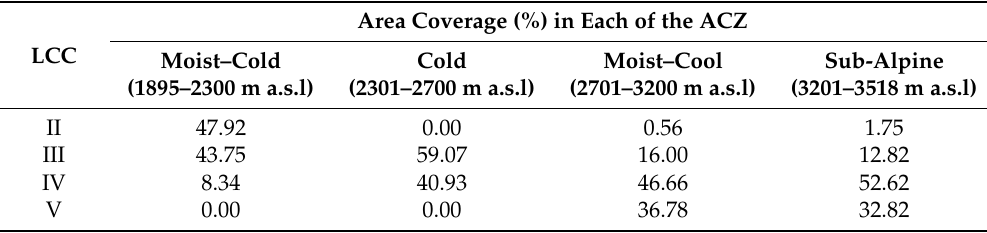
Table 6. Area coverage land capability classes (LCCs) among the ACZs of the study site.